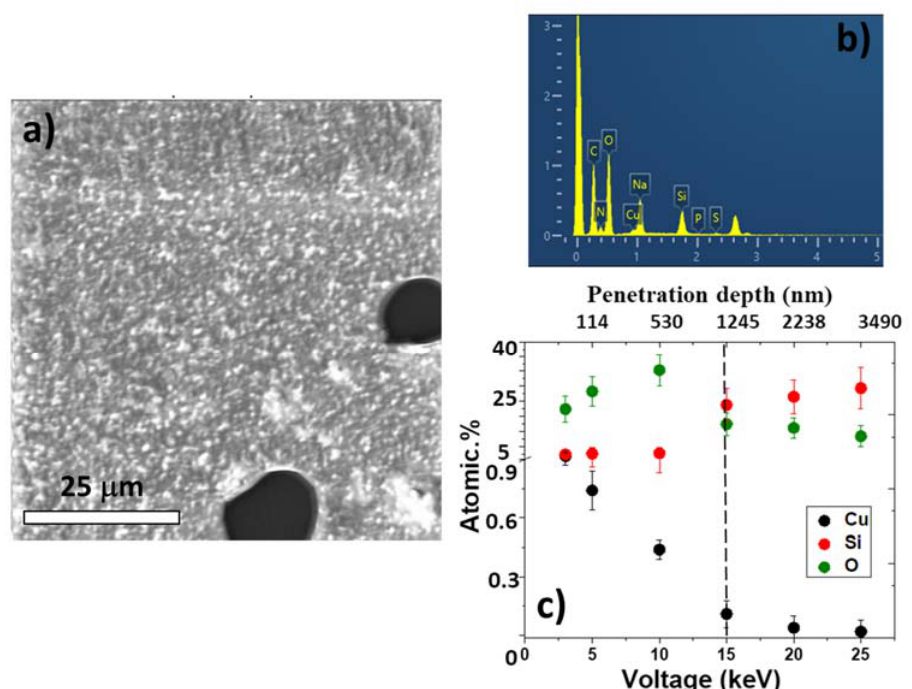
Figure 9. SEM visualization of the Salmonella bacterial biofilm with transferred copper NPs ( a ); its EDX spectrum (5 keV) ( b ). In-depth EDX distribution of oxygen (biofilm component), silicon (substrate component), and copper (component of transferred NPs), derived from their voltage dependences ( c ). The vertical dashed line indicates the Si substrate position and the rear side of the biofilm.